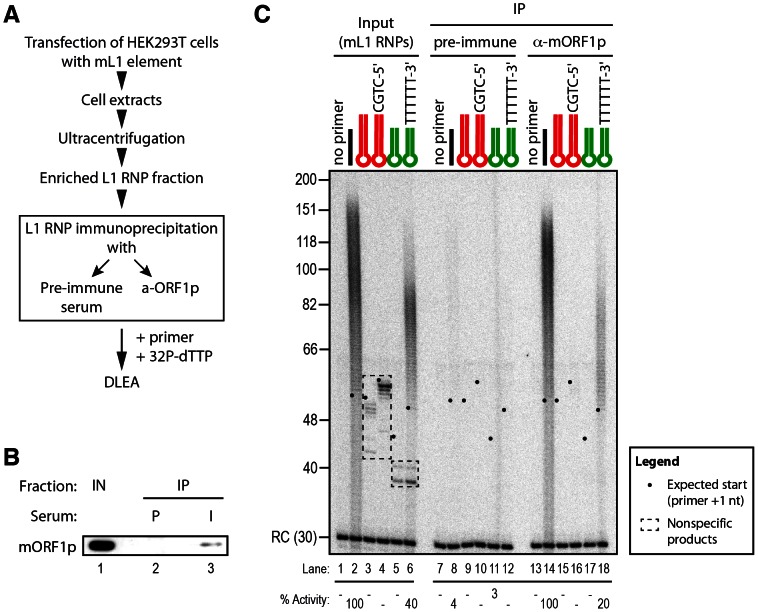
Priming of reverse transcription by immunopurified mL1 RNP.(A) Outline of the experimental procedure. (B) Immunoblot of the mL1 RNP immunoprecipitation (IP). IPs were performed on mL1 RNP preparations (Input, IN, lane 1) using preimmune (P, lane 2) or mORF1p-immune (I, lane 3) sera. Blot was probed with the anti-mORF1p serum. (C) Primer extension assay performed with mL1 RNPs (lanes 1–6), beads of the preimmune serum IP (lanes 7–12) or beads from the anti-mORF1p serum IP (lane 13–18). Note that the products suspected to be nonspecific (dashed boxes, lanes 3–6) indeed result from contaminating cellular activities and disappear upon immunoprecipitation, while the specific reverse transcription products are still observed (lanes 14 and 18). RC denotes a 30 nt recovery control added after the reaction but before DNA purification. Quantification of primer extension (% Activity) was relative to levels of extension obtained with ext-(dT)18 (lane 2 for Input and lane 14 for IP). The black dots on the left side of each lane indicate the expected start of reverse transcription. Their position varies since primer length varies.